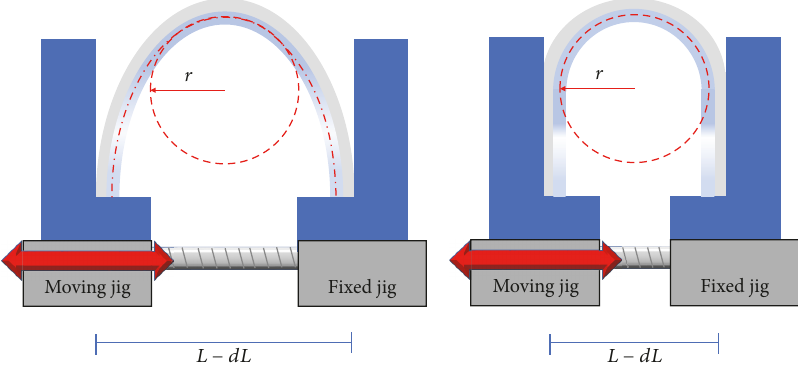
Figure 3: Schematic diagram of bending test.